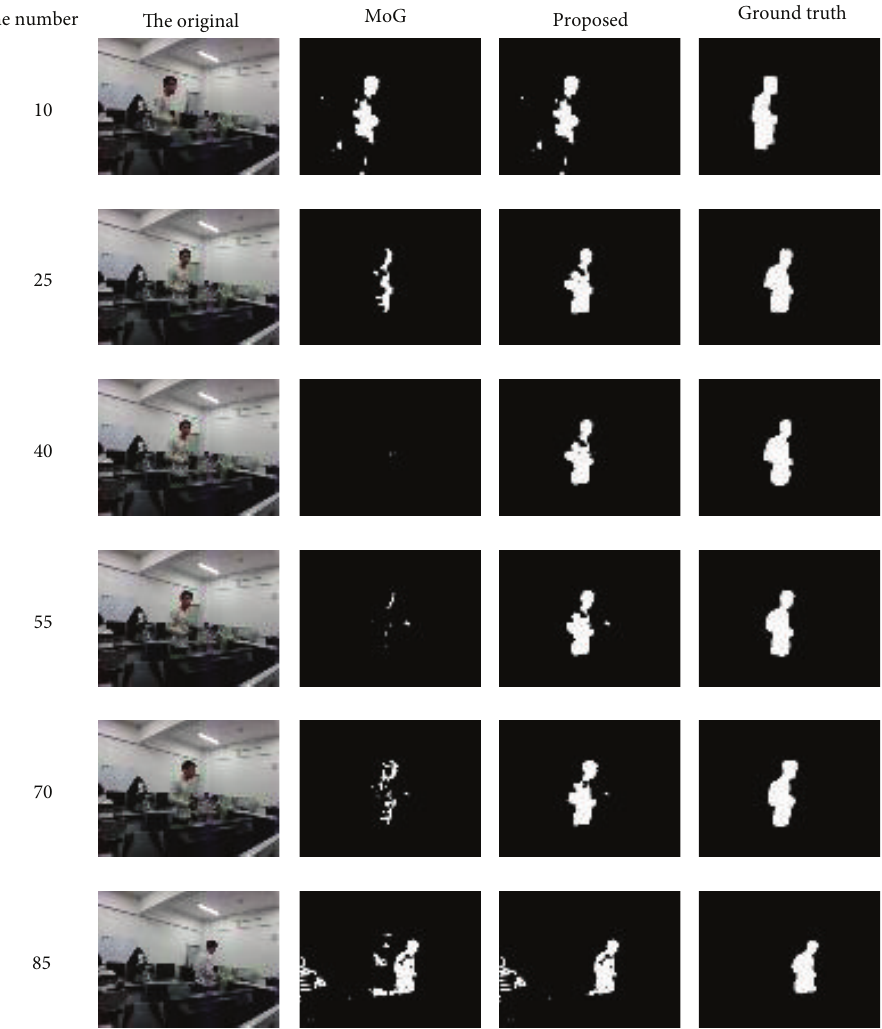
Figure 6: Examples of foreground segmentation results comparing the proposed method with the original